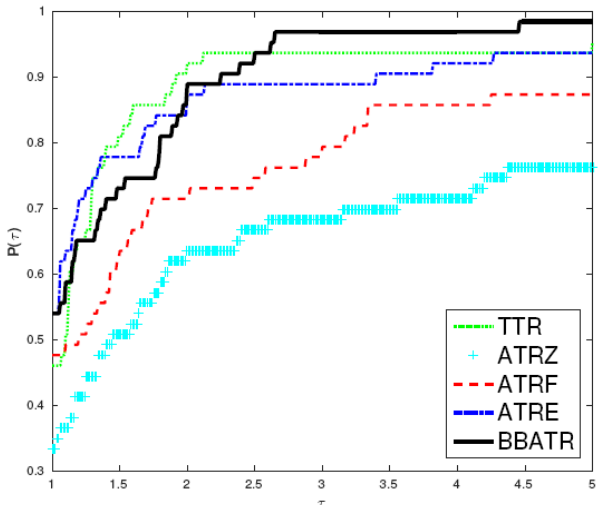
Figure 2. Function evaluations performance profile for the presented